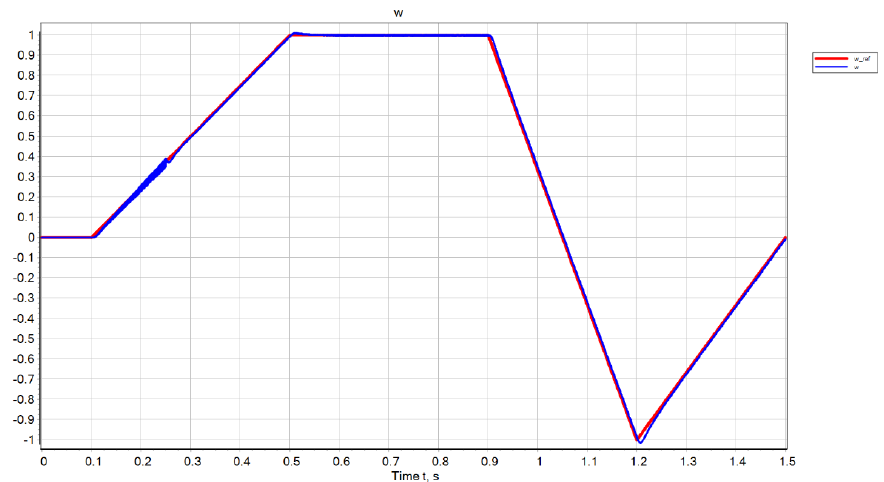
Figure 6. Set angular velocity and angular velocity of the motor at a load moment of inertia of 0.7 kg · m 2 .